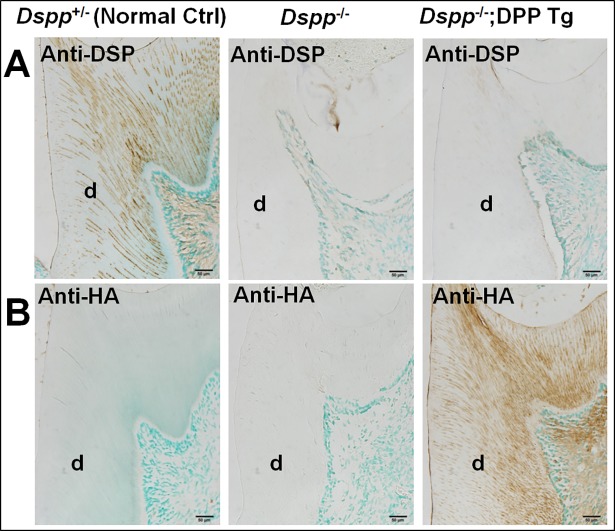
Immunohistochemical detection of DSP and Col1a1-HA-DPP in the mandibular first molars of 3-month-old Dspp+/-, Dspp-/- and Dspp-/-;DPP Tg mice.Immunohistochemical staining showed the presence of the anti-DSP signals (brown color) in the dentin matrix (d) of the Dspp+/- mice (A, left image), but not in the Dspp-/- (A, middle image) and Dspp-/-;DPP Tg mice (A, right image). Note the presence of HA-DPP (Anti-HA) signals in the Dspp-/-;DPP Tg mice (B, right image). Scale bars = 50 μm.